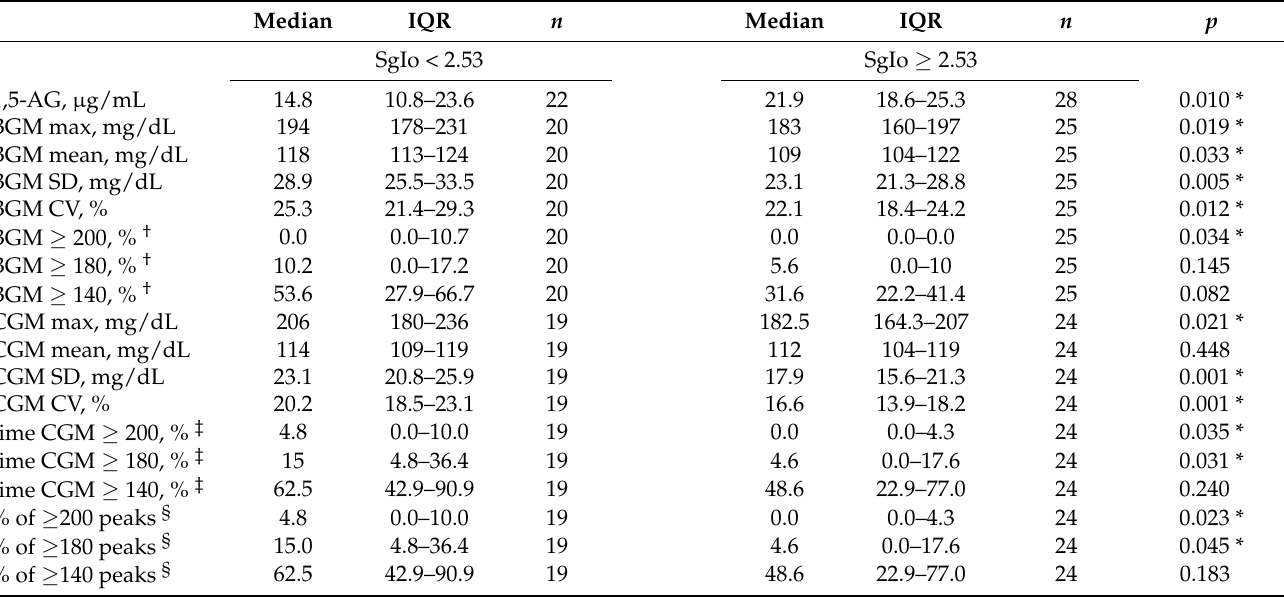
Table 4. The median and interquartile range of indices for postprandial hyperglycemia stratified with SgIo categories.